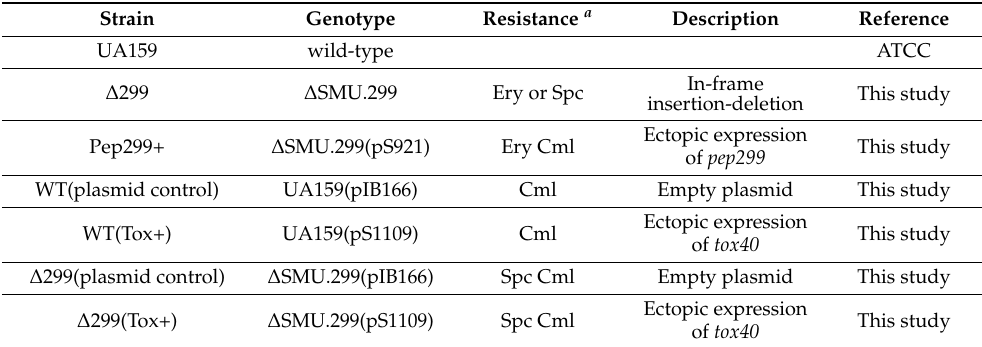
Table 1. S. mutans strains used in this